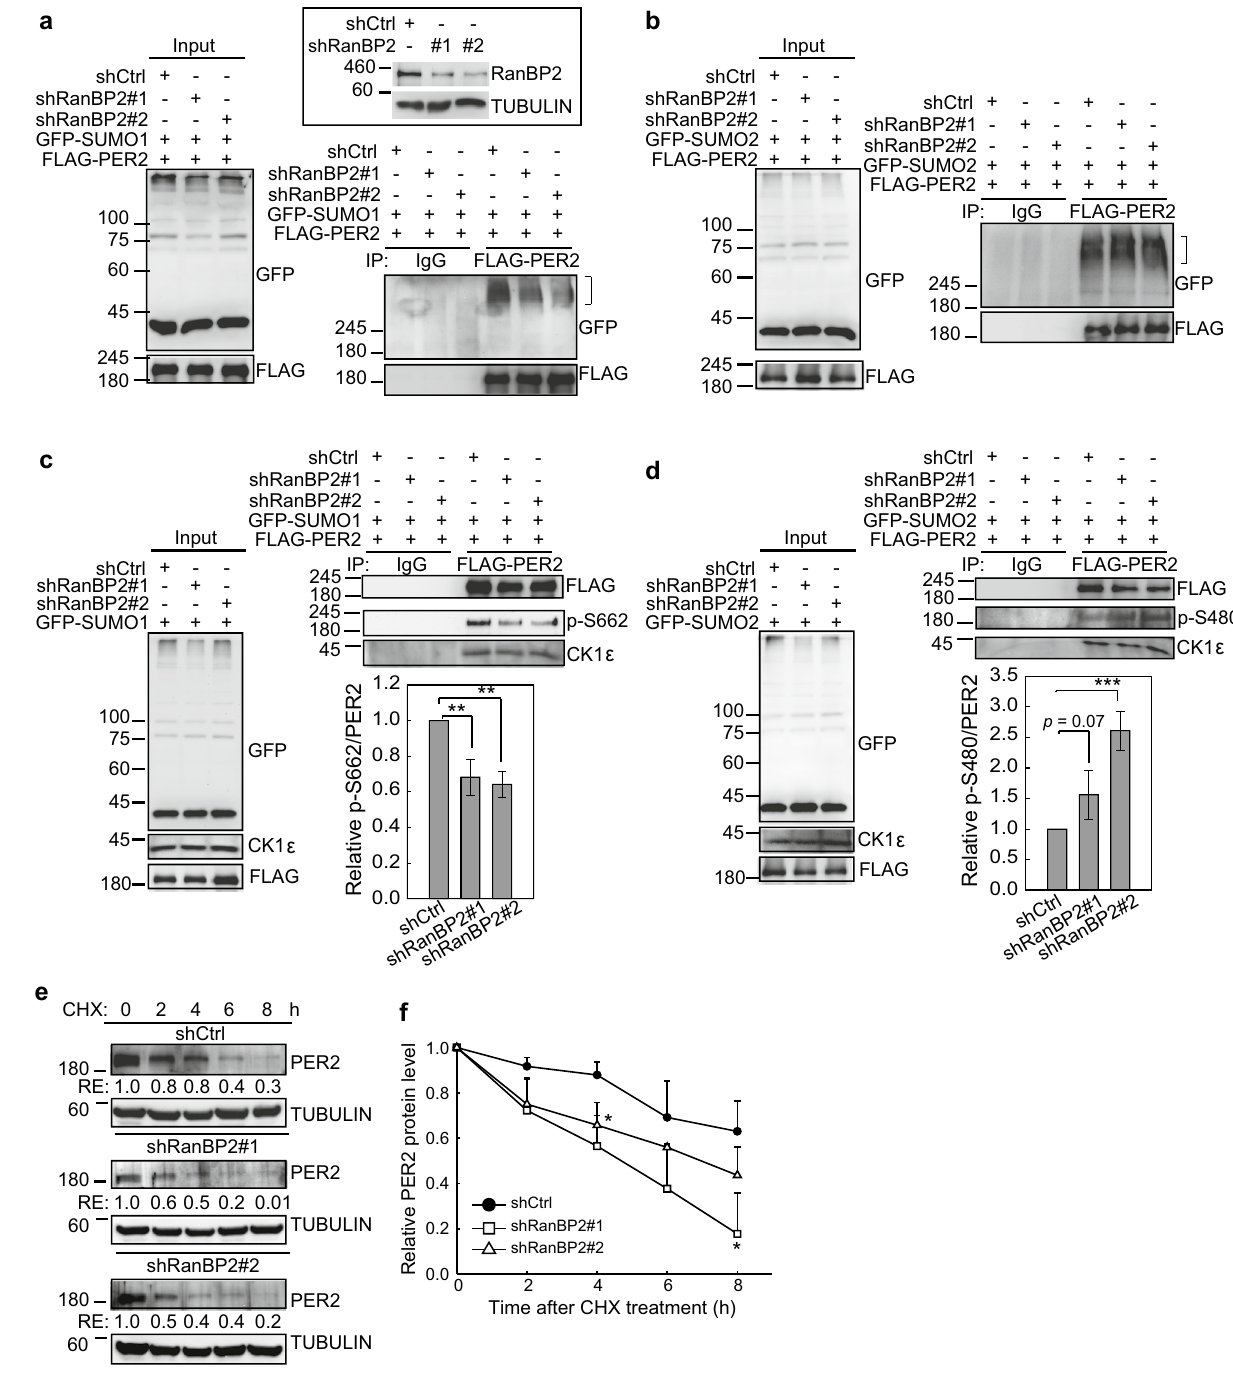
Figure 4. PER2 SUMO1 conjugation is mediated by RanBP2. ( a ) Co-IP assay using U2OS cells without or with RanBP2 depletion co-transfected with FLAG-PER2 and GFP-SUMO1. Cell lysates were IP with anti-FLAG antibody and analyzed by IB to detect PER2- SUMO1 conjugates indicated by brackets (lower right panel). The depletion efficiency of RanBP2 protein was determined using IB analysis (upper right panel). ( b ) Co-IP assay using U2OS cells without or with RanBP2 depletion co-transfected with FLAG-PER2 and GFP-SUMO2. Cell lysates were IP with anti-FLAG antibody and analyzed by IB to detect PER2-SUMO2 conjugates indicated by brackets. ( c ) Co-IP assay using U2OS cells without or with RanBP2 depletion co-transfected with FLAG-PER2 and GFP-SUMO1. Cell lysates were IP with anti-FLAG antibody and analyzed by IB to detect CK1 and S662-phosphorylated PER2. Quantification of relative S662-phosphorylated PER2 protein levels (p-S662/FLAG-PER2) is from three Co-IP analyses. Data are means ± SD. ( d ) Co-IP assay using U2OS cells without or with RanBP2 depletion co-transfected with FLAG-PER2 and GFP-SUMO2. Cell lysates were IP with anti- FLAG antibody and analyzed by IB to detect CK1 and S480-phosphorylated PER2. Quantification of relative S480-phosphorylated PER2 protein levels (p-S480/FLAG-PER2) from three Co-IP analyses. Data are means ± SD. ( e ) Time course assay using CHX treated U2OS cells without or with RanBP2 depletion. The levels of endogenous PER2 was determined using IB analysis. TUBULIN was used as a loading control. RE: relative expression. ( f ) Quantification of relative endogenous PER2 protein levels from three IB analyses as described in e. Data are means ± SD. * p < 0.05 (Student’s t-test). For ( a – e ), the membranes were cut prior to hybridization with antibodies. The original blots and additional experiments with similar results are shown in the “Supplementary information”